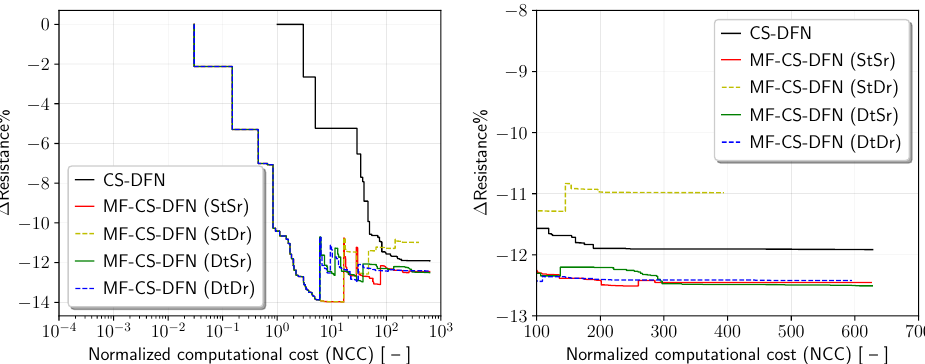
Figure 4. Whole optimization convergence ( left ) and a detail of the last iterations ( right ). The resistance reduction is evaluated with respect to the original hull with the grid used during the optimization